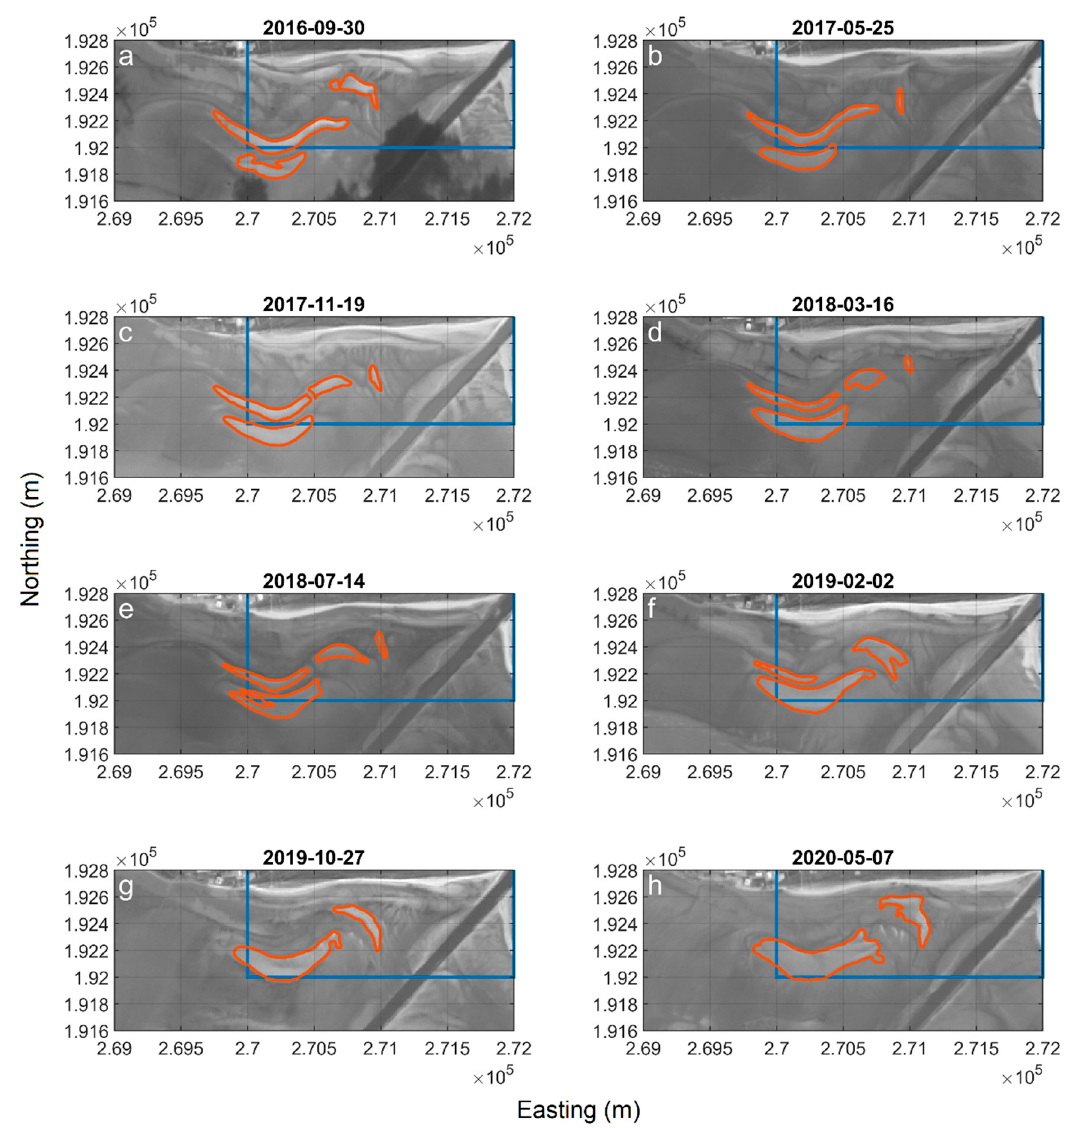
Figure 11. Grayscale images of the intertidal at low tide with key sandbars determined from grayscale intensity contours marked in orange, and the area of maximum drone flight coverage marked in blue, for the dates ( a ) 30 September 2016, ( b ) 25 May 2017, ( c ) 19 November 2017, ( d ) 16 March 2018, ( e ) 14